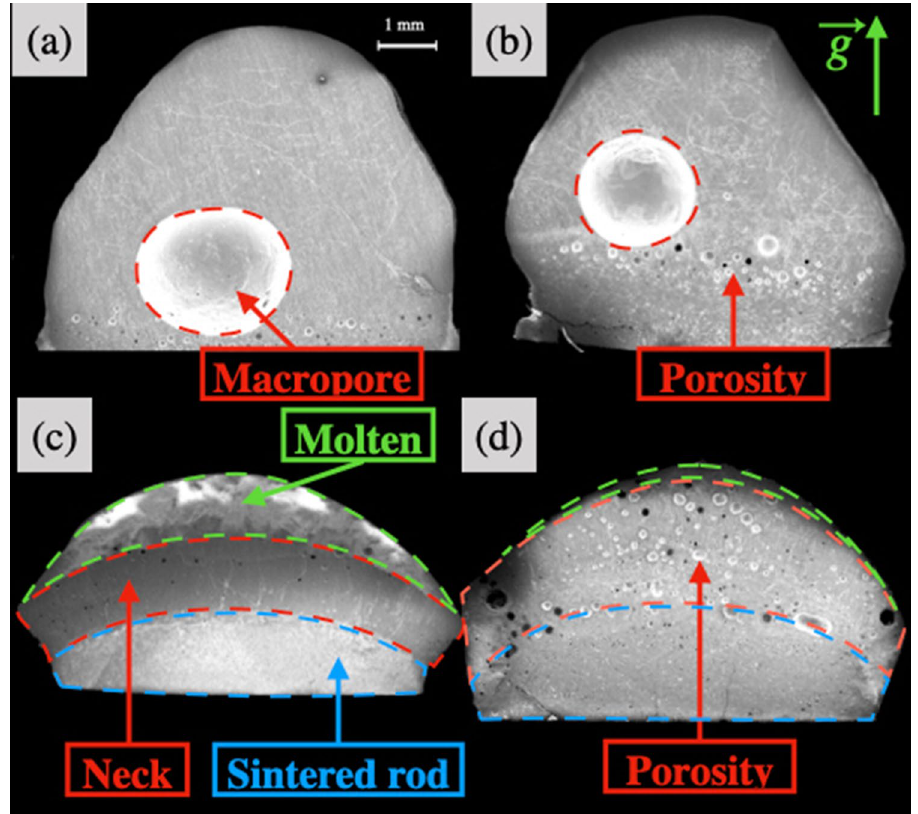
Figure 4. SEM (JEOL JSM- 6610LV, JEOL Ltd.) images of (BaS) 0.25 - ( La 2 S 3 ) 0.75 solidified droplets maintained at